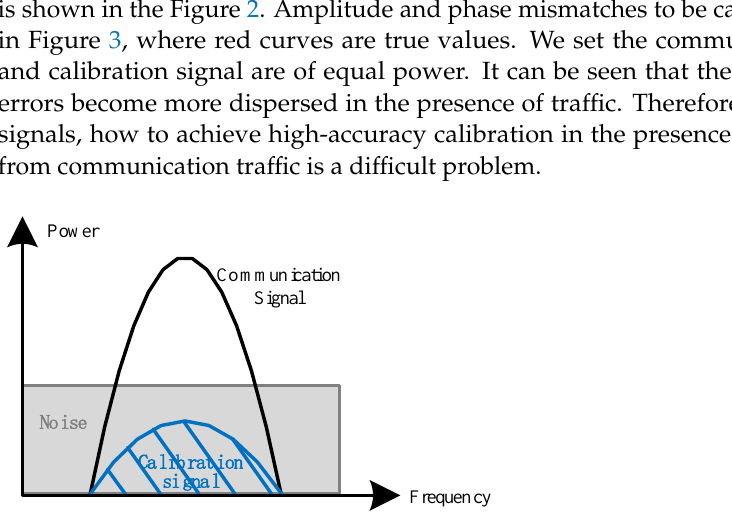
Figure 2. Power level relationship of communication signal, calibration signal and